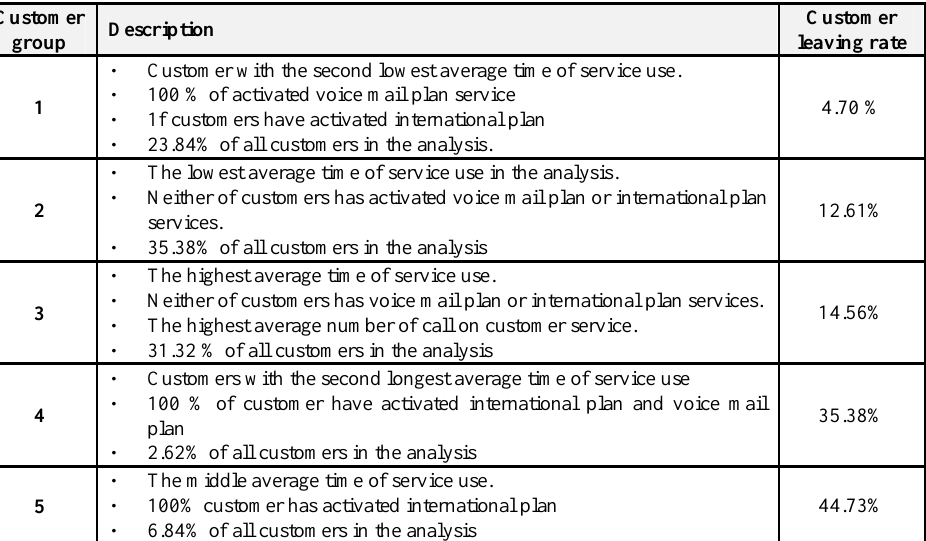
Table 2 – Description of customers